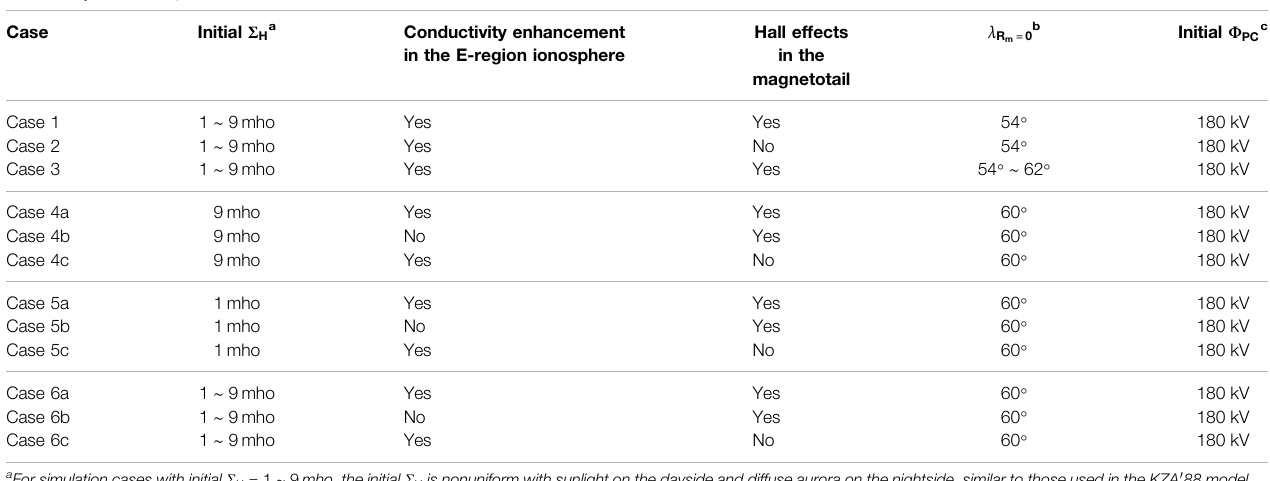
FIGURE 2 | SimulationresultsobtainedfromCase1simulation.Case1ischaracterizedbytime-independent R m and R m showcolor-levelplotsof Σ H obtainedatthe10thstepandthe15thstepofthesimulation,respectively.Panels (C) and (D) showcolor-levelplotsoftheupward fi eld-alignedcurrent density J z obtainedfromthesimulationatthe10thstepandthe15thstep,respectively.Strong fi eld-alignedcurrentsandenhancedHallconductancesappearinthemidnightregion.